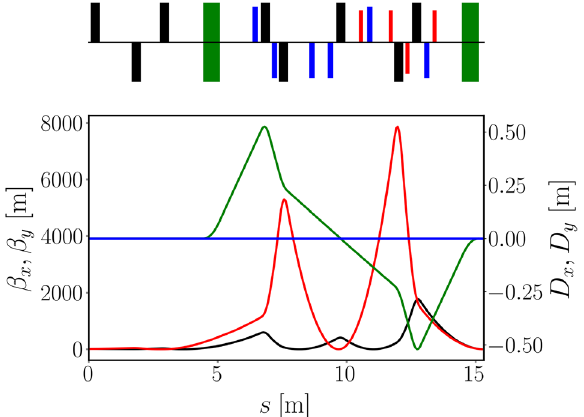
FIG. 6. MAD - X simulation of the transfer line design after the optimization of the sextupole and octupole positions and strengths. Twiss parameters β (black), β (red), and dispersion x y D (green) and D (blue) are shown below, with a synoptic x y overview of the transfer line above, with dipoles (green), quadru- poles (black), sextupoles (blue), and octupoles (red).